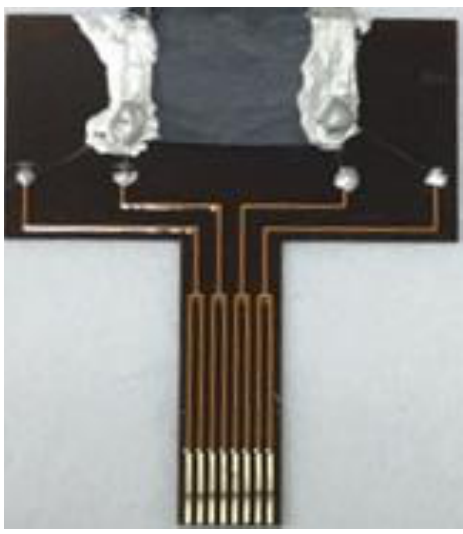
Figure 2. The fabricated hydrogen sensor.